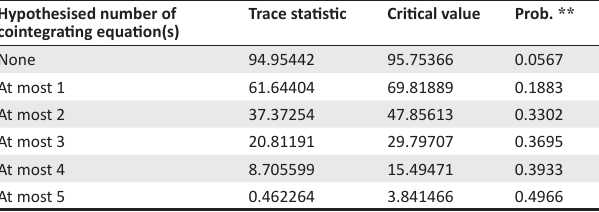
Trace statistic